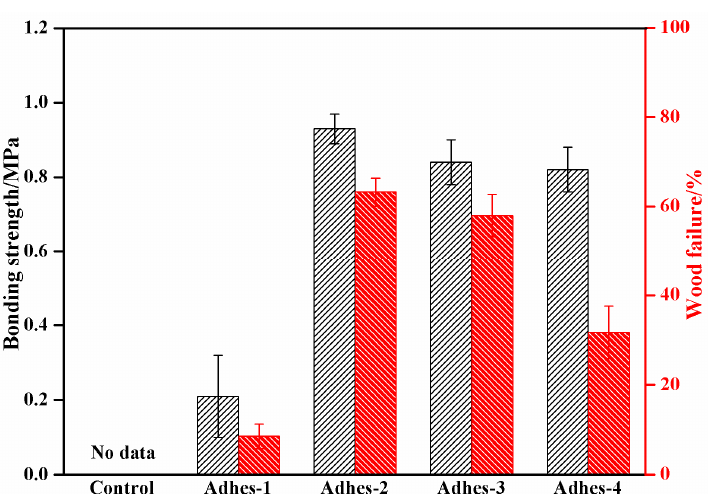
Figure 9. Results of bonding strength and wood failure of Camellia oleifera cake-protein adhesives. Note: Control, pure Camellia oleifera cake-protein hydrolysate; Adhes-1, the pure Camellia oleifera cake-protein adhesive; Adhes-2, Camellia oleifera cake-protein adhesive modified with DSP; Adhes-3, Camellia oleifera cake-protein adhesive modified with SPI; Adhes-4, Camellia oleifera cake-protein adhesive modified with casein.